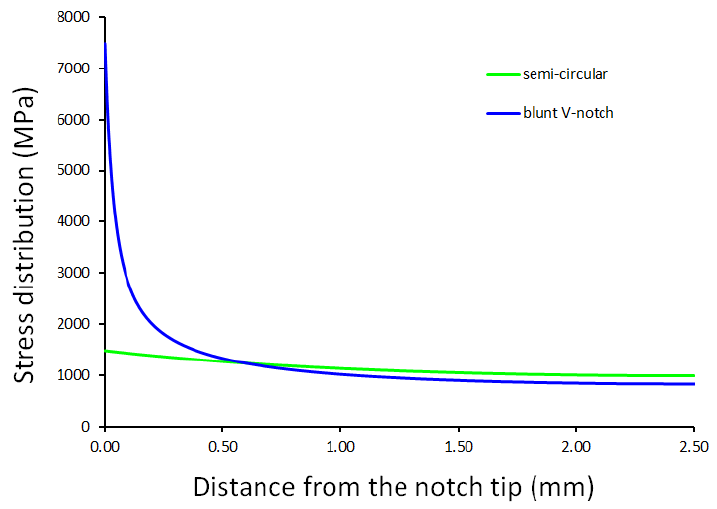
Figure 6. Semi-circular and blunt V-notched stress distribution ahead of the notch tip used